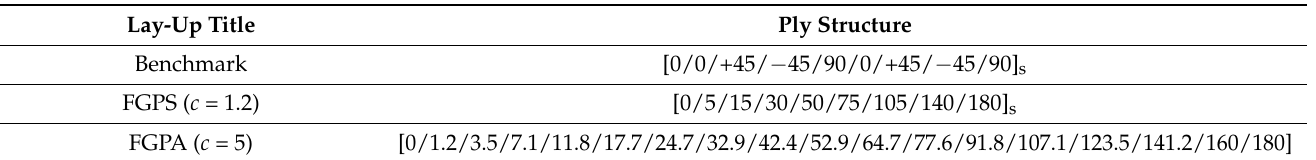
Table 1. Bioinspired composite designs based on the mantis shrimp dactyl club. Lay-Up Title